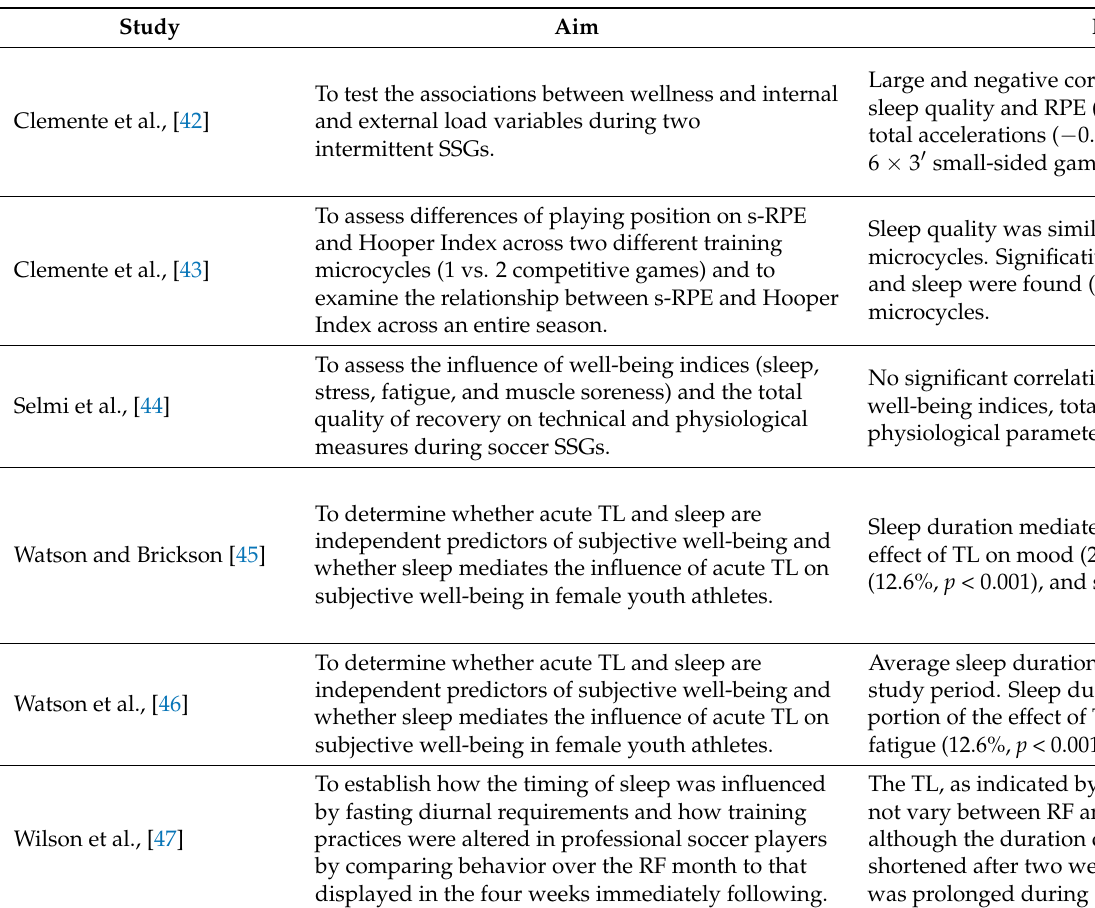
Table 5. Results concerning sleep and training